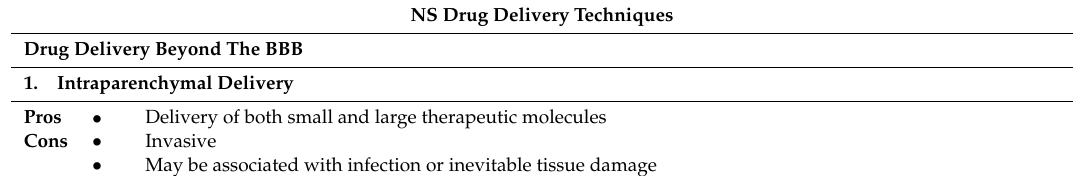
Table 2. Summary of CNS drug delivery